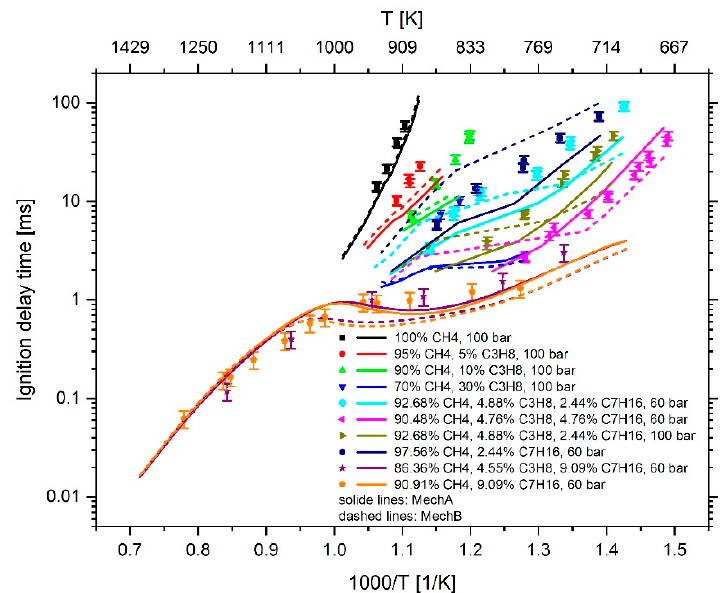
Figure 3. Experimental data (symbols) [12,13] versus model prediction (lines) using the mechanism MechA (solid lines) and MechB (dashed lines). The respective content of methane, propane, and n -heptane is given in mol% and corresponds to the values in Table 1.